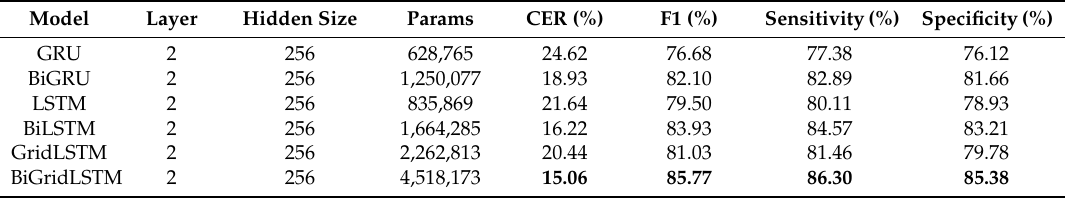
Table 2. CER comparison of bidirectional models and unidirectional models. The bold data in table indicates the minimum CER and highest sensitivity, specificity, and F1 in the